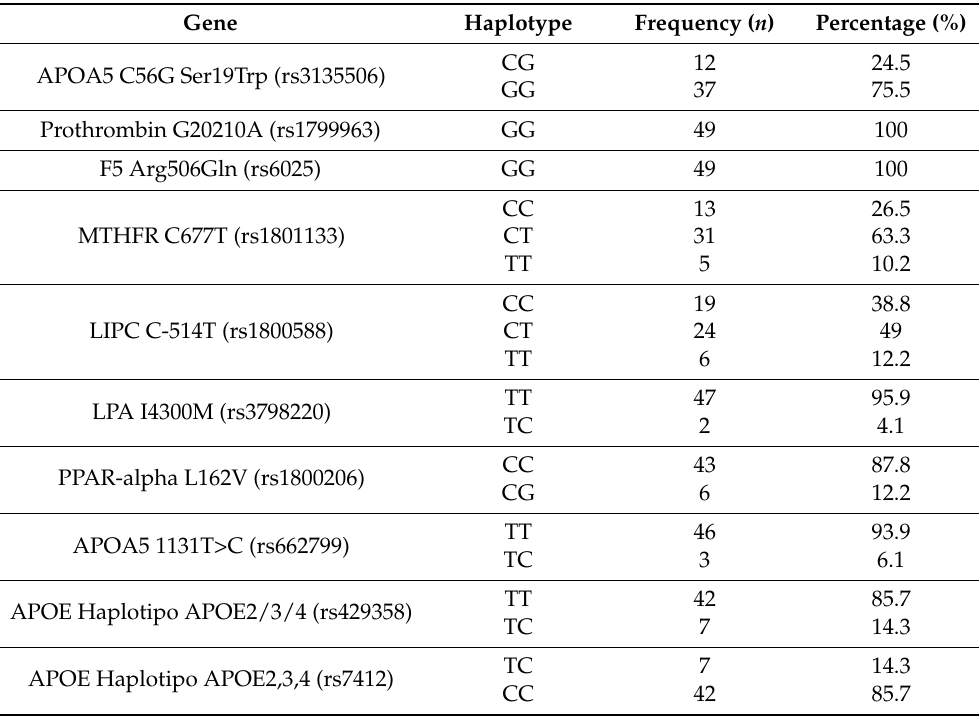
Table 2. Descriptive statistics of genes and